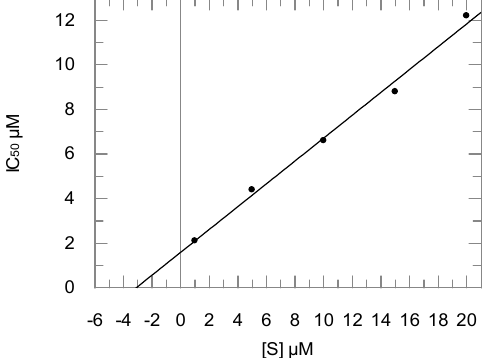
Figure 1. Dependence of inhibition potency (IC 50 values) on substrate concentration for inhibition of cathepsin L by compound 7 . Increasing IC 50 values at increasing substrate concentrations indicate a competitive inhibition mode.